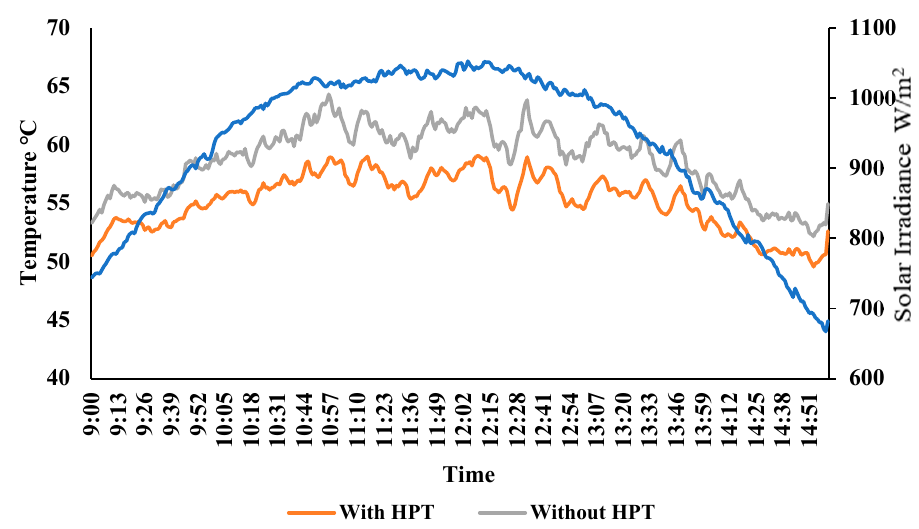
Figure 7. The temperature reference PV panel and the PV panel with 100 mL acetone.